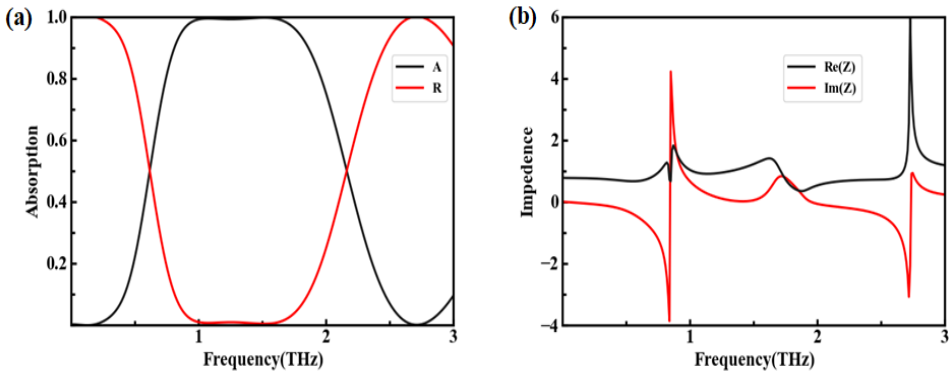
Figure 4. Absorption performance and equivalent impedance. ( a ) Absorption and reflection spectra; ( b ) real and imaginary parts of impedance Z.